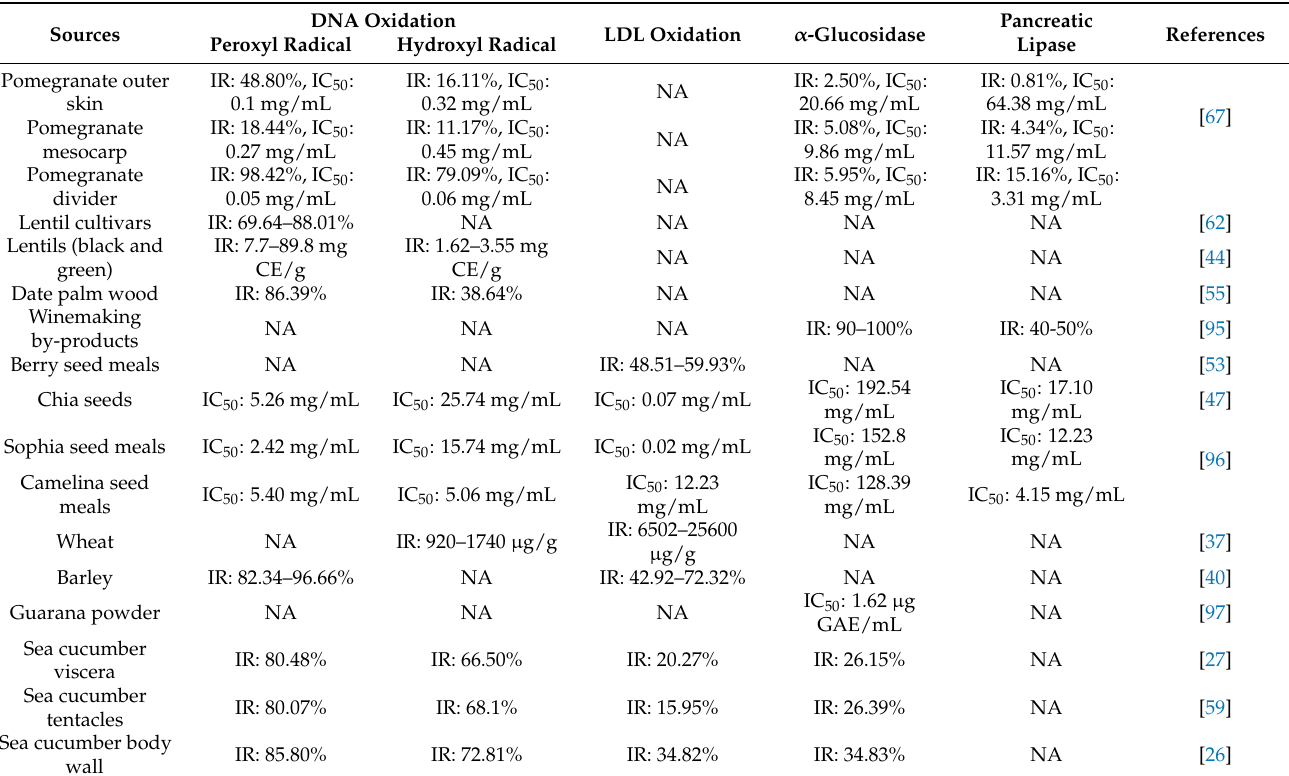
Table 5. Biological activities of IBPs obtained from various